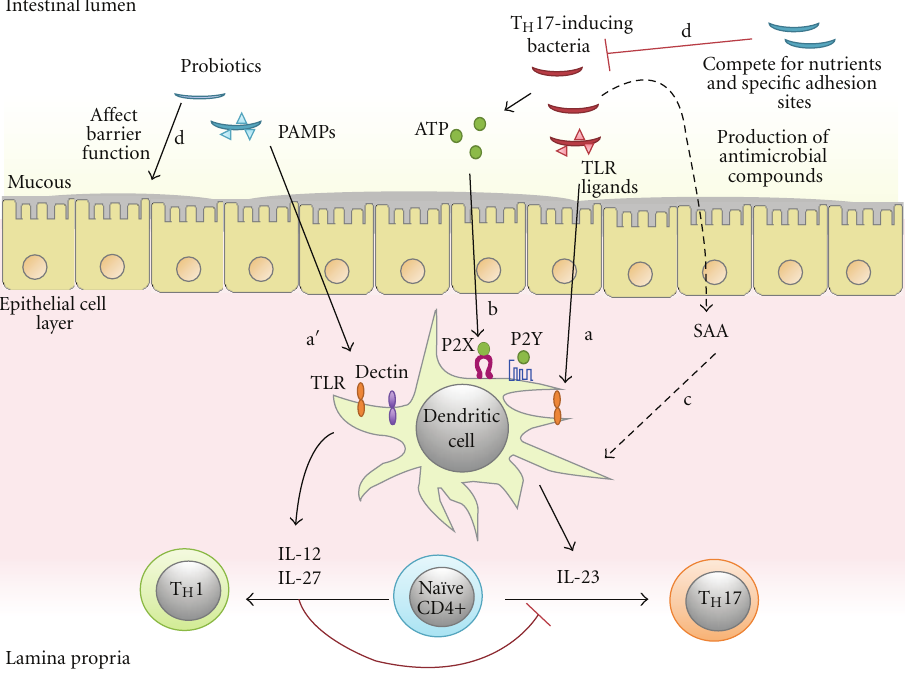
Figure 2: A simplified diagram showing the possible mechanisms of intestinal bacteria in influencing the polarization of T H 17 cells in the lamina propria. Activation of dendritic cells by intestinal microbes results in secretion of proinflammatory cytokines such as IL-12, L-23, IL- 27. T H 17-inducing bacteria may promote T H 17 immunity via IL-23 induction, which may involve signaling mediated by the TLR ligands (a), extracellular ATP (b), and SAA (c). Meanwhile, some probiotic strains may skew immunity away from T H 17 via IL-12 and IL-27 induction as a result of activating TLR and dectin receptors (a (cid:2) ). These cytokines can inhibit T H 17 development while facilitate T H 1 di ff erentiation. Probiotic may also work by controlling the growth and colonization of T H 17-inducing bacteria (d). IL: interleukin; P2X: ionotropic receptors; P2Y: metabotropic receptors; PAMPs: pathogen-associated molecular patterns; SAA: serum amyloid A; TLR: toll-like